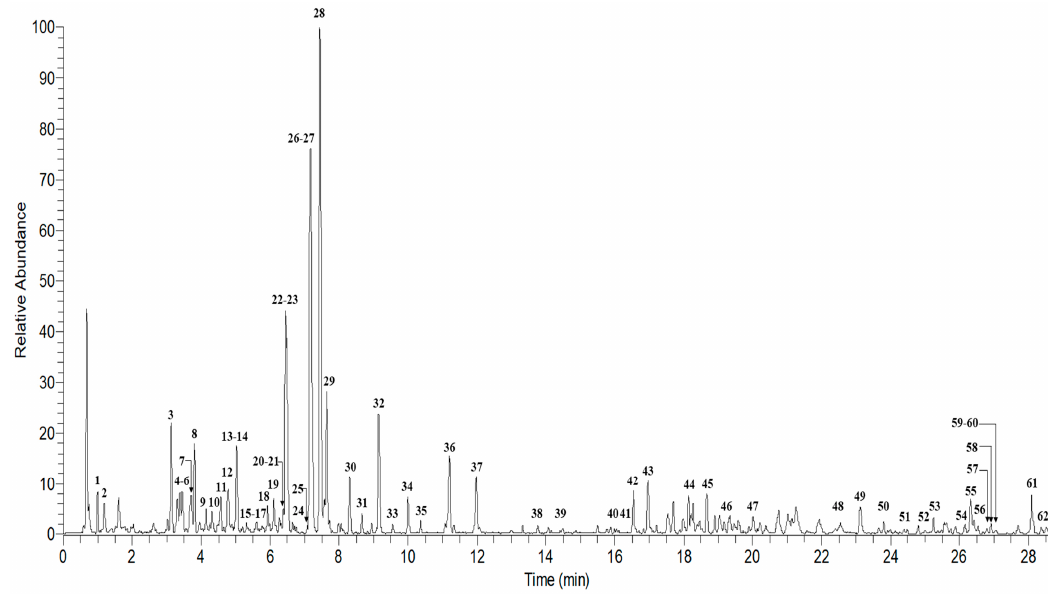
Figure 1. Total ion chromatogram of 70% ethanolic leaves extract of A. elliptica.